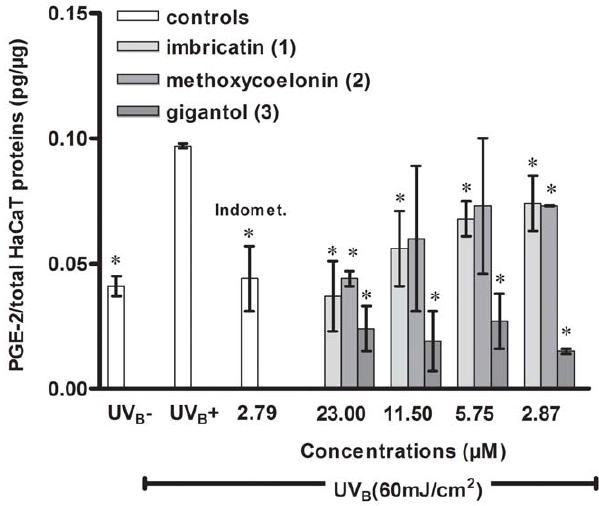
Table 2. Reactive Oxygen Species (ROS) neutralization in H 2 O 2 stressed HaCaT cells. Figure 4. Concentration-dependent effect of stilbenoids 1–3 on